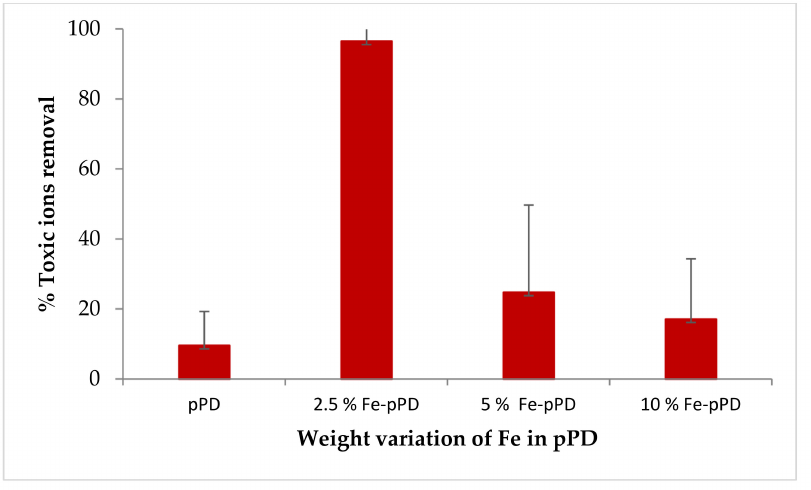
Figure 1. Percent removal of pPD and % Fe in pPD adsorbents for As 3+ and F − uptake (initial concentration: 10 mg/L, adsorbent dose 0.4 g, and contact time 30 min at 297